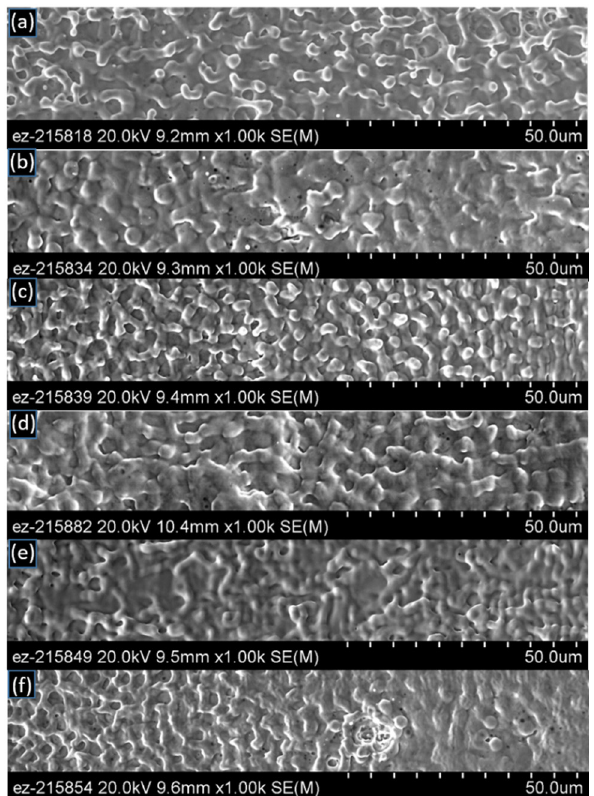
Figure 6. SEM micrographs (2000×) of the laser-interference-processed area using the spot-by-spot method with a 4 mm spot size on copper. Each frame shows a different number of pulses per spot: